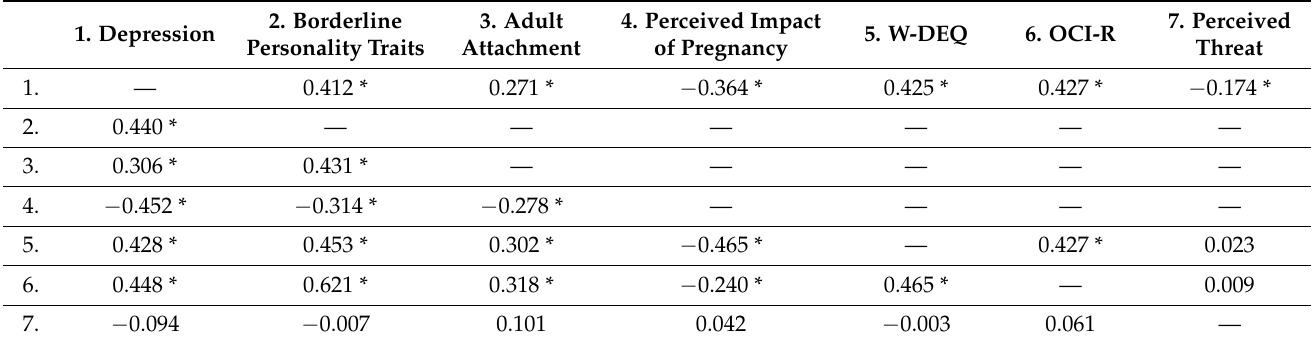
Table 2. Correlations between the variables used in this study.